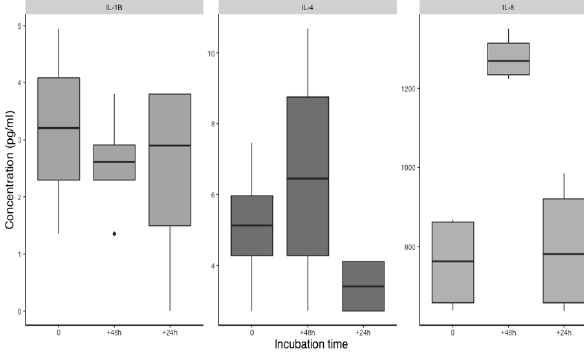
Figure 4. Incubation for 48 h - clarithromycin impact on pro- inflamma- tory mediators’ secretion. Figure shows the impact of clarithromycin, respectively, on IL-1β, IL-4 and IL-8 release by A459 cells. Before (incuba- tion time 0), after co-incubation (incubation time +48h), and 24 h after wash-out (incubation time +24h), cell culture supernatants were ana- lysed for the presence of the indicated cytokines by Luminex®. Values are expressed as mean ± SEM from 4 independent